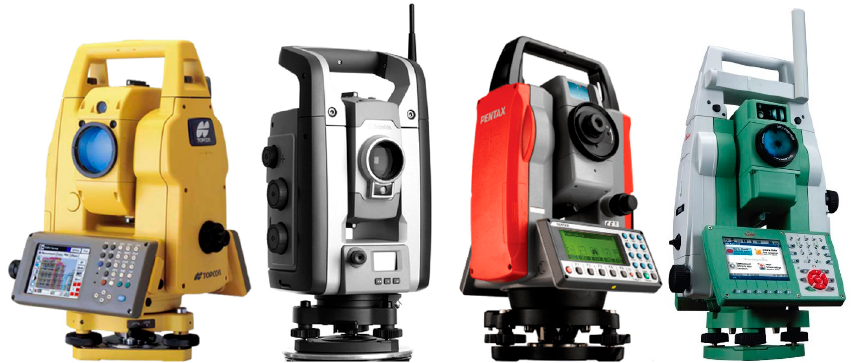
Figure 8. First commercial IATS from Topcon (GPT-7000i) [41], from Trimble (VX Spatial Station) [43], from Pentax (Visio model R-400VDN) [44], and from Leica Viva (TS11/TS15) [45].